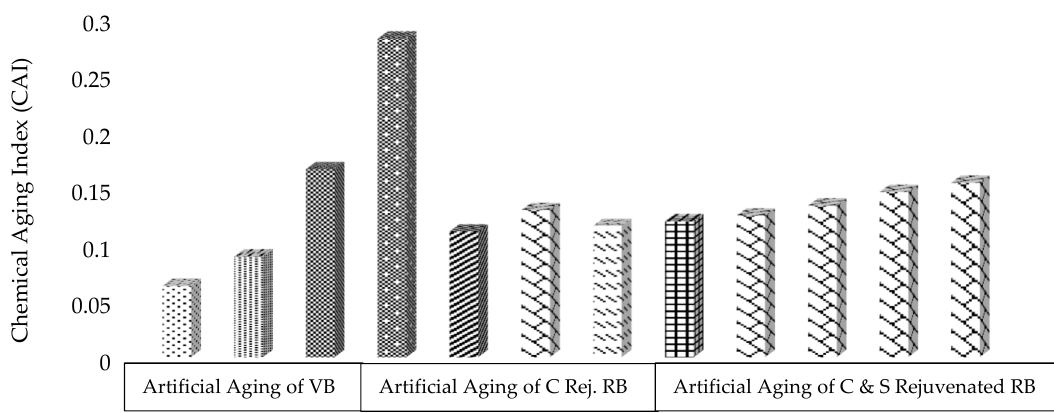
Figure 8. Effect of rejuvenation and aging on the chemical aging index (CAI) of binders.